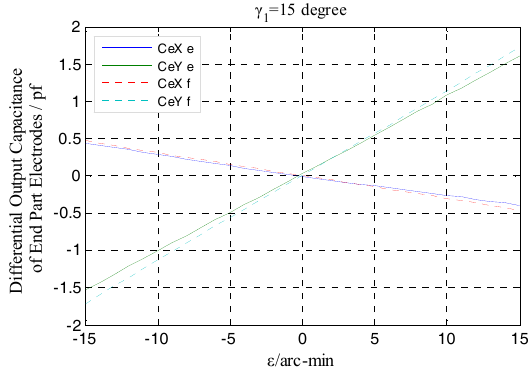
Figure 27. Comparison of experimental and simulation values of the end part differential output capacitance.